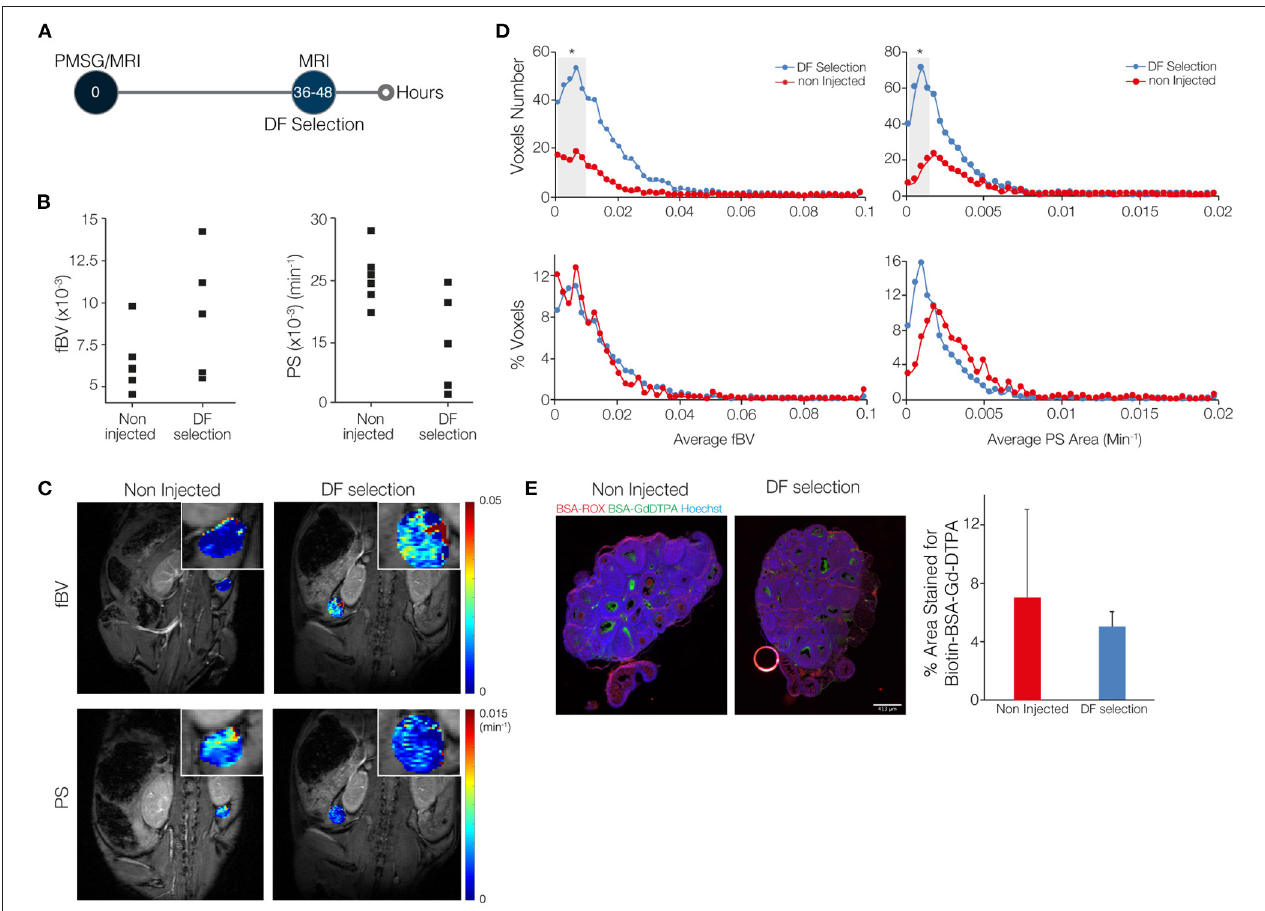
FIGURE 1 | The angiogenic process that accompanies dominant follicle (DF) selection is characterized by a low blood volume and low permeability. (A) Mice were imaged by DCE-MRI 36–48h after injection of PMSG ( n = 5), soon after DF selection, and were compared to sexually immature non-injected control mice, with no DF in their ovaries ( n = 6). (B) Fractional blood volume (fBV) and permeability surface area product (PS) averaged over the entire ovary voxels. (C) Maps of fBV and PS showing the value for each voxel in the ovary region of interest. Enlarged ovary region is shown in the inset. (D) Histogram analysis of the total number and percent of voxels in each value range of fBV and PS. Ranges with significant increase in voxels with low values of fBV and low values of PS are indicated in gray background (* represents p -value <0.05). (E) Fluorescent staining for the MRI contrast agent, b-BSA-GdDTPA (intra and extravascular at 35min after injection; visualized using fluorescent streptavidin) and for BSA-ROX (confined mainly to the blood vessels at 2min after injection). Red circle is an air bubble. Percent area covered by the b-BSA-GdDTPA staining was